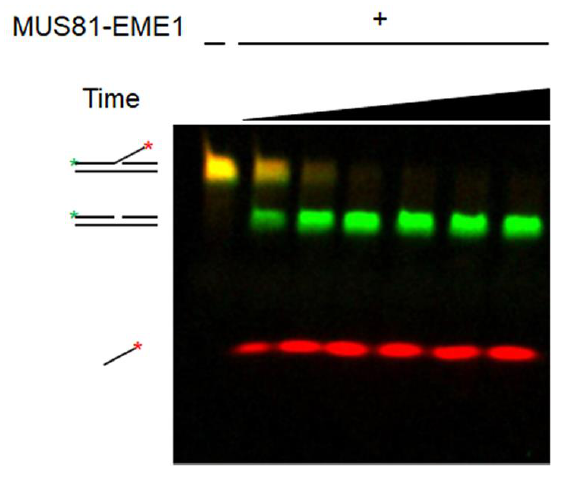
FIGURE 11: Gel-based endonuclease assay using a fluorescent substrate. Time course analysis for 1, 3, 5, 7, 10, and 15 minutes with 100 nM of the Cy3/Cy5 3’ -flap substrate and 5 nM human MUS81-EME1 visualized on a 10% native acrylamide gel with Cy3 and Cy5